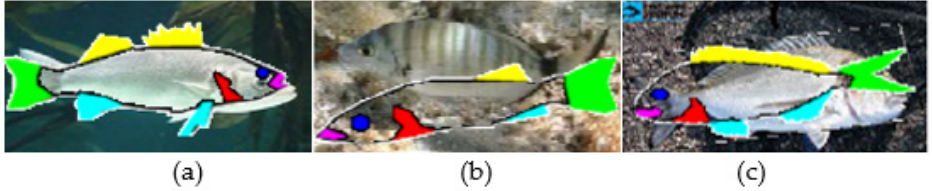
Figure 10. Example output images from the Contour2 flow, showing an acceptable matching ( a ), matching error in the size and position ( b ) and matching error in the size, position and orientation ( c ).